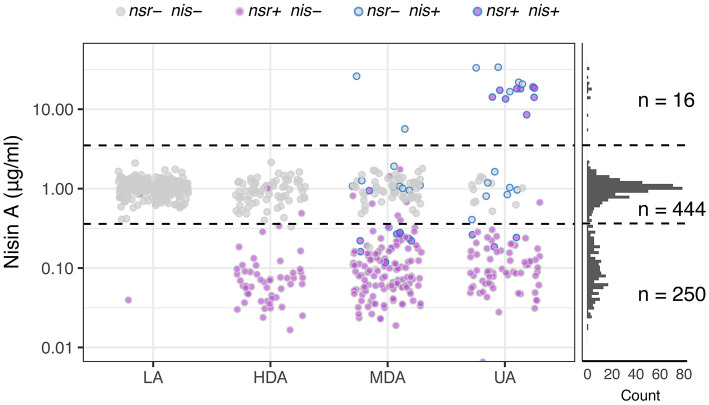
Nisin degradation by individual L. lactis strains. Dot plots depicting nisin A concentrations as quantified with HPLC-MS/MS after incubating 0.9 μg ml−1 of nisin A in milk inoculated with L. lactis strains belonging to one of the four phenotypic groups LA, HDA, MDA and UA. Dots are further color-coded to indicate the presence or absence of nsr and/or nisin biosynthesis genes (nis) in the tested strain. The right panel displays the distribution of resultant nisin A concentrations derived from the complete set of tested strains (n = 710). Horizontal dashed lines are drawn to indicate the boundaries between observations showing an increase of nisin A (16 datapoints above 3.5—upper dashed line), an unchanged nisin A concentration (444 datapoints between dashed lines) or a decreased nisin concentration (250 datapoints below 0.36—lower dashed line).